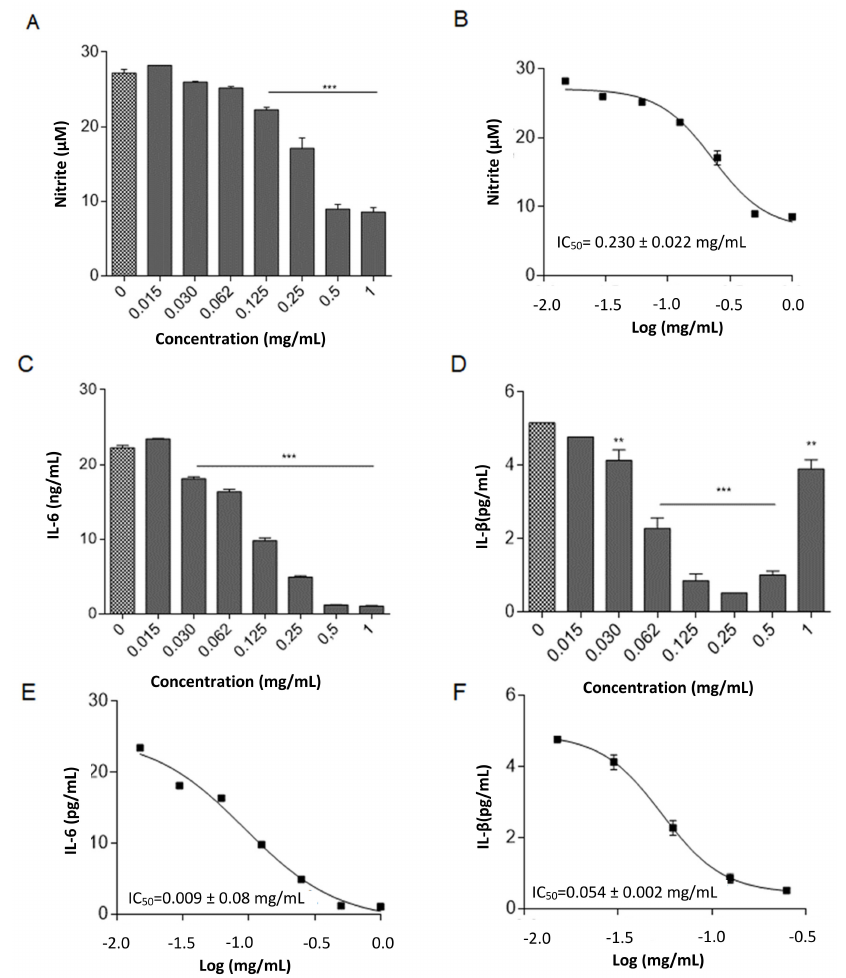
Figure 4. ( A ) LPS-activated RAW 264.7 cells were in vitro stimulated using di ff erent OLE